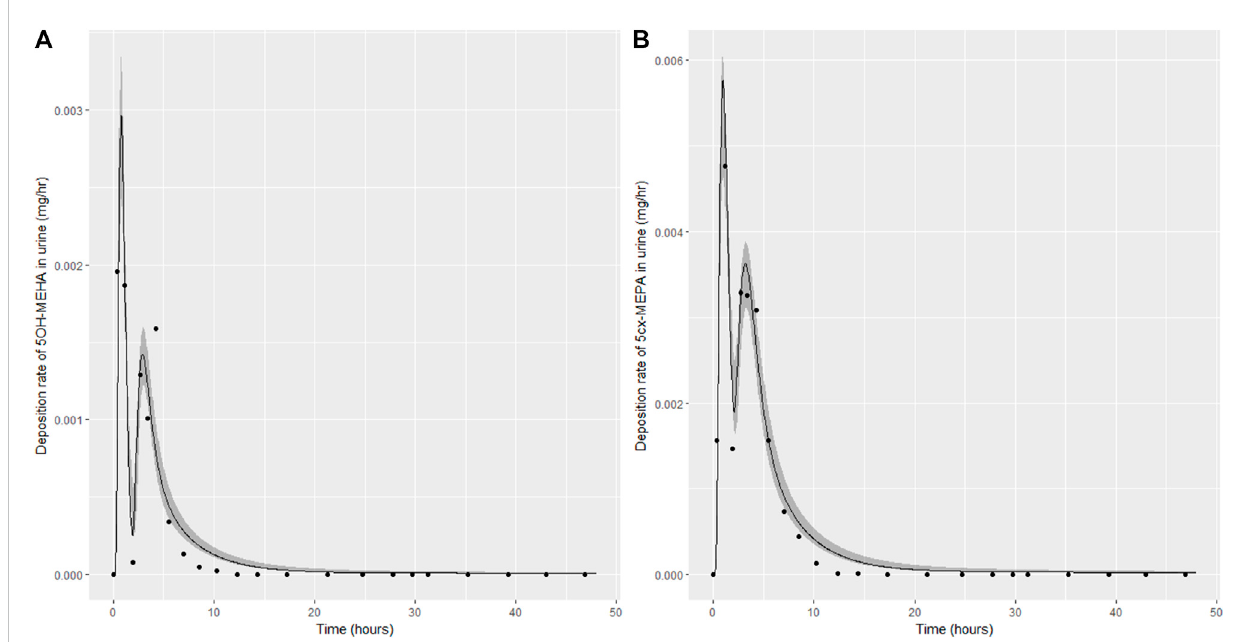
Simulation of the urinary excretion (mg/h) of 5OH-MEHA (A) and 5cx-MEPA (B) for volunteer